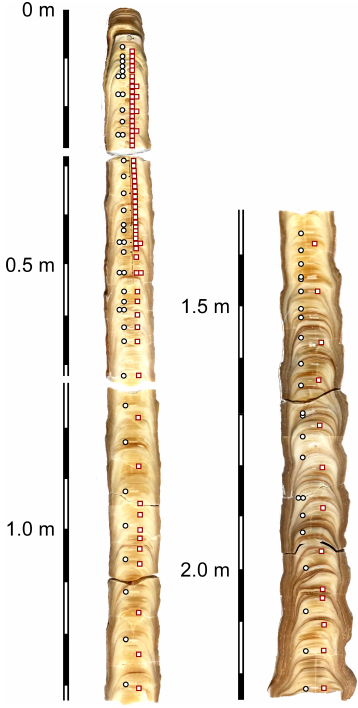
Figure 2. Composite photograph of stalagmite M1-5 from Moomi Cave. Black circles indicate where U-series dating samples were taken; red squares represent 14 C sample